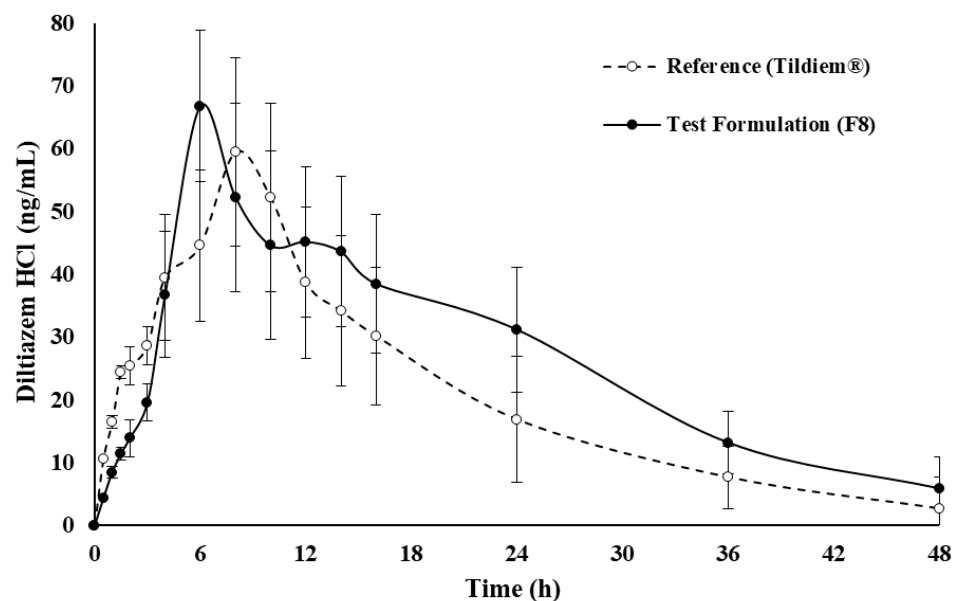
Figure 7. Plasma concentration of DLZ after oral administration of the commercial reference Tildiem ® (60 mg tablet) and test formulation (F8), each point represents the mean ± SD, n = 12. Table 5. Pharmacokinetic parameters of DLZ after in vivo oral administration of the commercial reference Tildiem ® (60 mg tablet) and test formulation (F8), data are mean ± SD, n = 12.